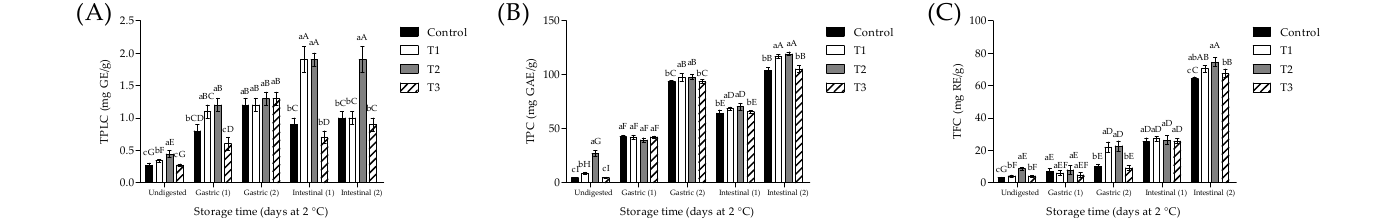
Figure 2. Total polysaccharide, phenolic, and flavonoid contents (( A ), ( B ), and ( C ), respectively) of cooked pork patties before and after ivGD. T1, POP at 2%; T2, POP at 5%; T3, BHT at 0.02%. Lowercase letters indicate differences between treatments on each sampling day; capital letters indicate differences in each treatment through the storage period ( p < 0.05).